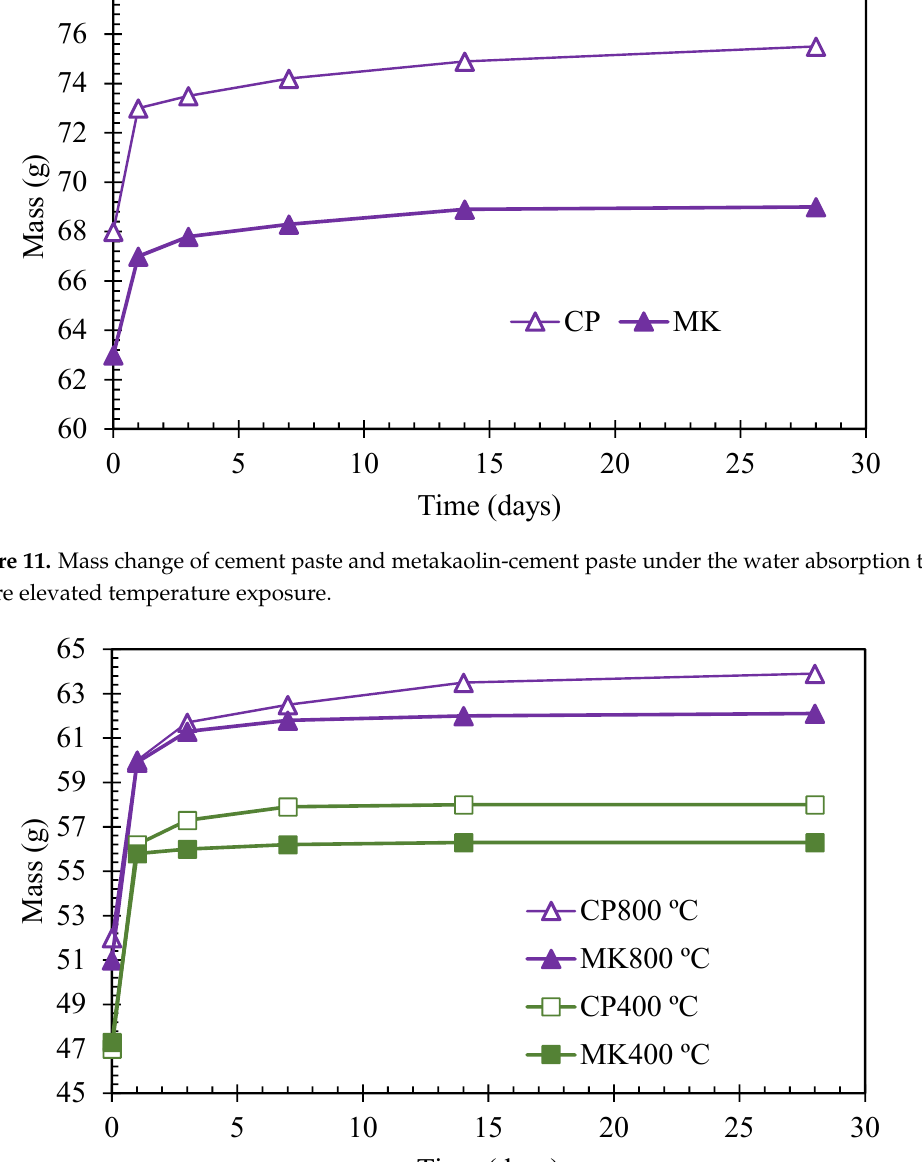
Figure 13. Water absorption of cement paste and metakaolin-cement paste.